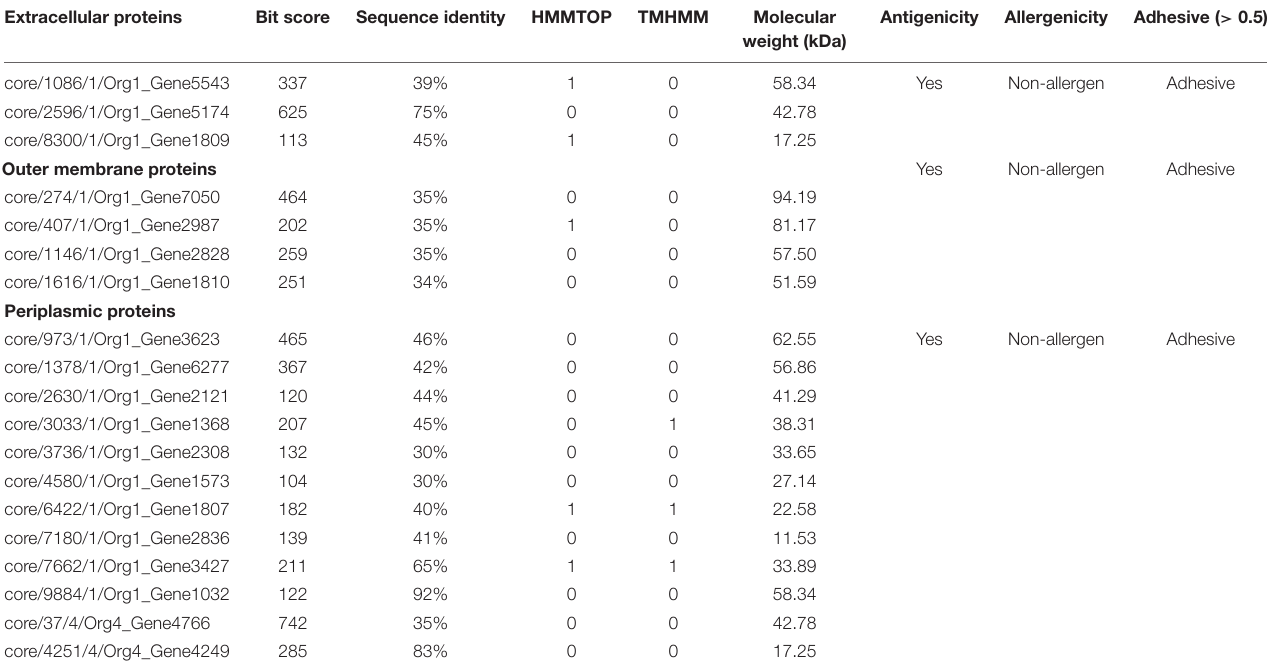
TABLE 2 | List of good vaccine targets filtered after several vaccine checks. Extracellular proteins Bit score Sequence identity HMMTOP TMHMM Molecular